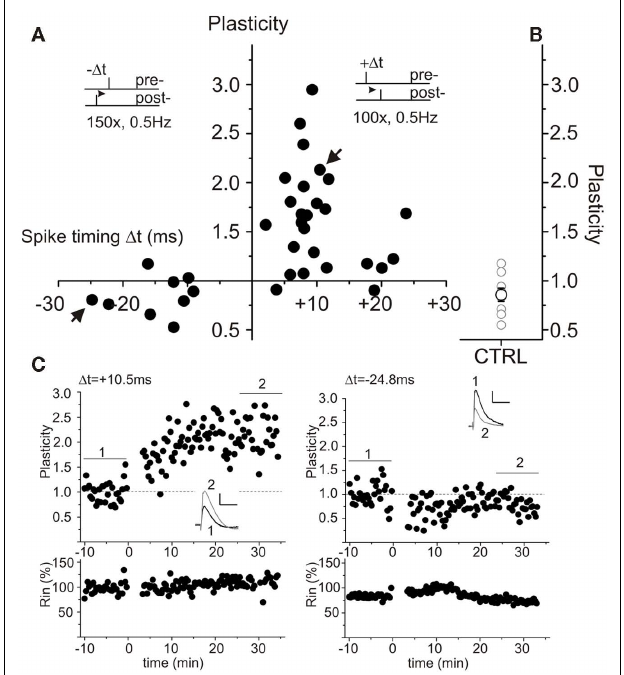
FIGURE 1 | Spike timing-dependent plasticity (STDP) inACSF prepared rat hippocampal slices. Synaptic responses were recorded in the current clamp mode in CA1 pyramidal neurons of juvenile rats (P15–P20). Pre-stimulus membrane potential prior to recording was − 70mV for all cells. Presynaptic stimulation of Schaffer collaterals was performed every 20s. (A) Single spike pairings at short positive ( Δ t =+ 2 to + 25ms) intervals lead to t-LTP. Negative ( Δ t =− 8 to − 25ms) pairings result in t-LTD. Insets show the employed pairing paradigms. (B) Summarized control measurements ( n = 9, mean ± SEM) without spike pairing in ACSF prepared slices. (C) Examples of single experiments for positive pairing (left) and negative pairing (right).The corresponding cells are indicated with arrows in (A) . Respective averaged original traces are shown as insets, analysis of input resistance is shown in the lower graphs. Bar scales: 1mV,